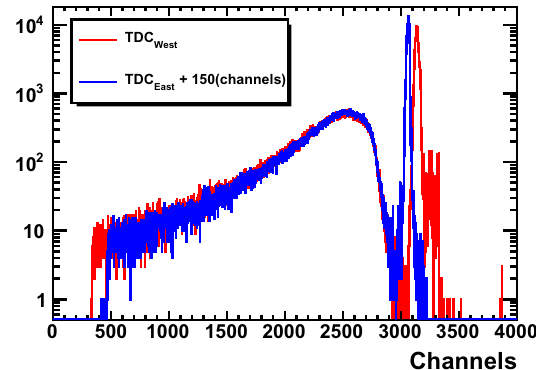
Figure 6. Shows the measured TDC response in the West (red) and East (blue) detectors. A flat channel shift is applied to the East detector which aligns the Type 1 backscatter peak with that of the West detector. A channel-to-time conversion is applied by setting the self-timing peak channel center to 140ns, i.e. the electronics setting. After conversion, the Type 1 backscatter peak matches the GEANT4 Monte Carlo. Note that there is a channel offset between the East and West self-timing peaks. This is attributed to additional dead-time in the West detector due to cable length differences. Bin width of ≈ 50ps.